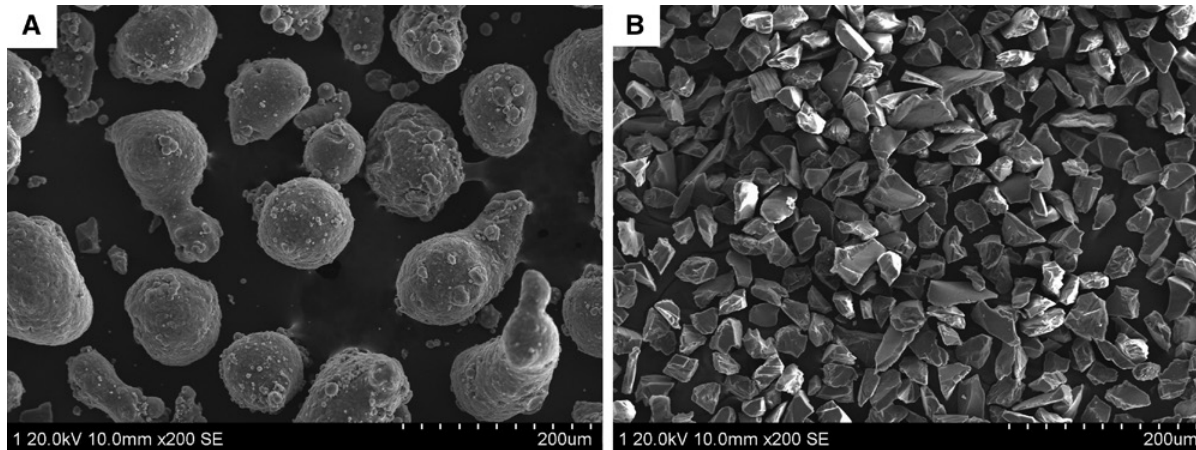
O powders in the experiments (A) pure Al powders (B) Al 2 3